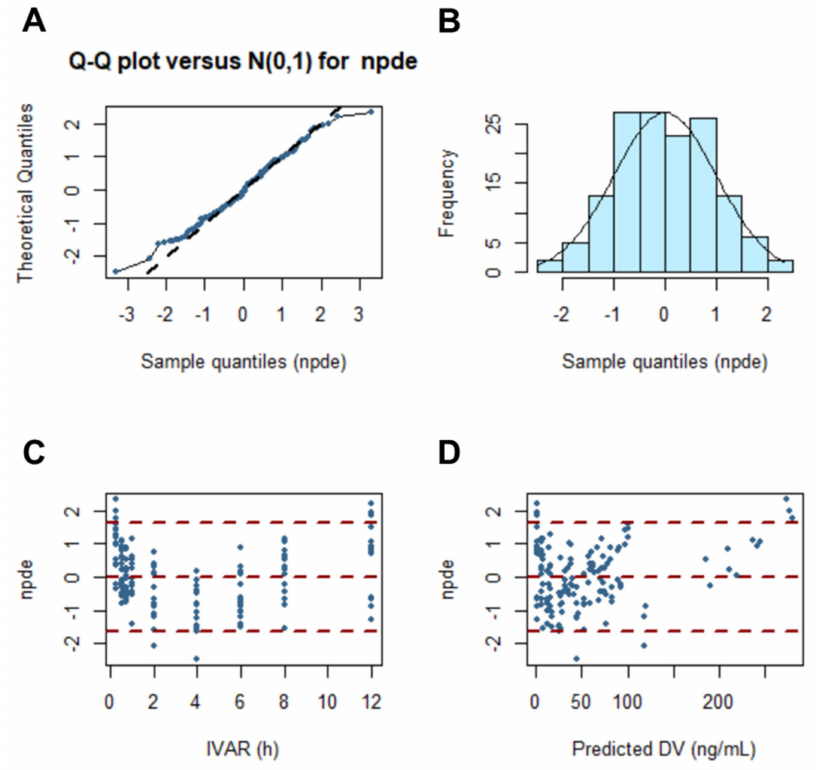
Figure 10. Normalized prediction distribution error for the final model of methotrexate-loaded nanoformulations. Quantile–quantile plots of normalized prediction distribution error vs. theoretical N (0, 1) distribution ( A ). Histogram showing the distribution of normalized prediction distribu- tion error overlaid with density of the standard Gaussian distribution ( B ). Scatter plot of time vs. normalized prediction distribution error ( C ). Scatterplot of predictions vs. normalized prediction distribution error ( D